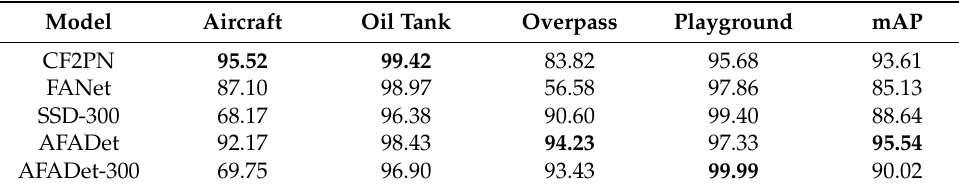
Table 3. mAP of each model for the ROSD